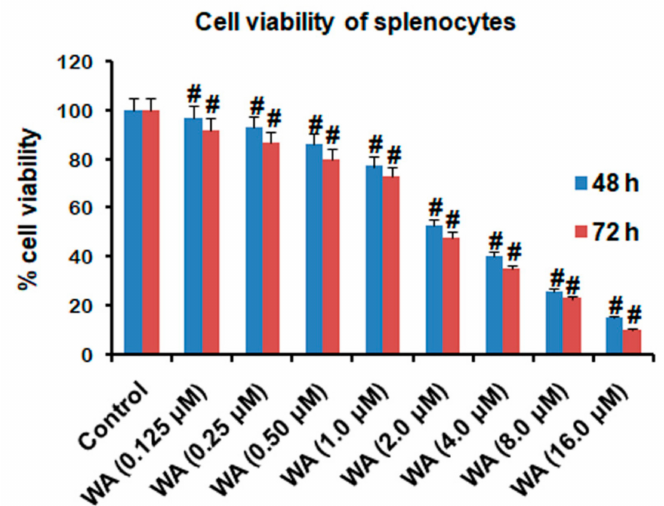
Figure 1. Cell viability of splenocytes isolated from BALB/c mice. After being seeded in a 96-well plate at a density of 10 4 cells per well, splenocytes were exposed to a range of doses of WA (0.125, 0.25, 0.5, 1.0, 2.0, 4.0, 8.0, 16.0 µ M) along with untreated splenocytes for 48 and 72 h to evaluate the cell viability of splenocytes after treatment with WA. Experimental data are presented as the mean ± SEM from three independent experiments. # p ≤ 0.05 is statistically